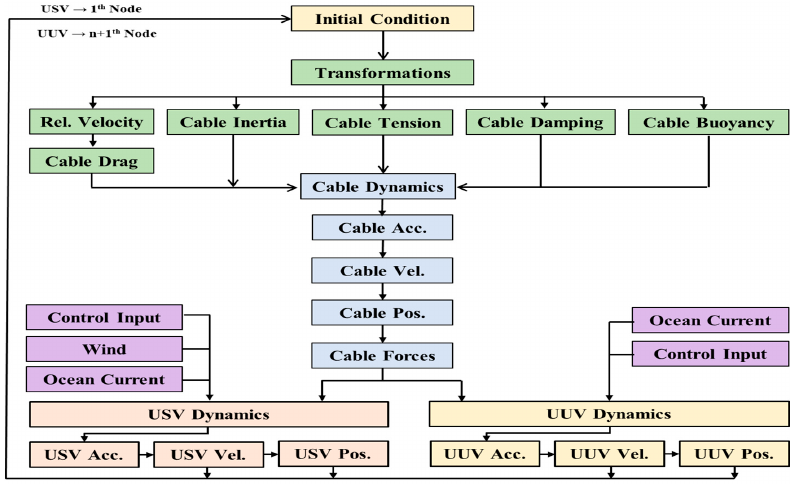
Figure 12. Flow chart of the unmanned ocean platform motion simulation.